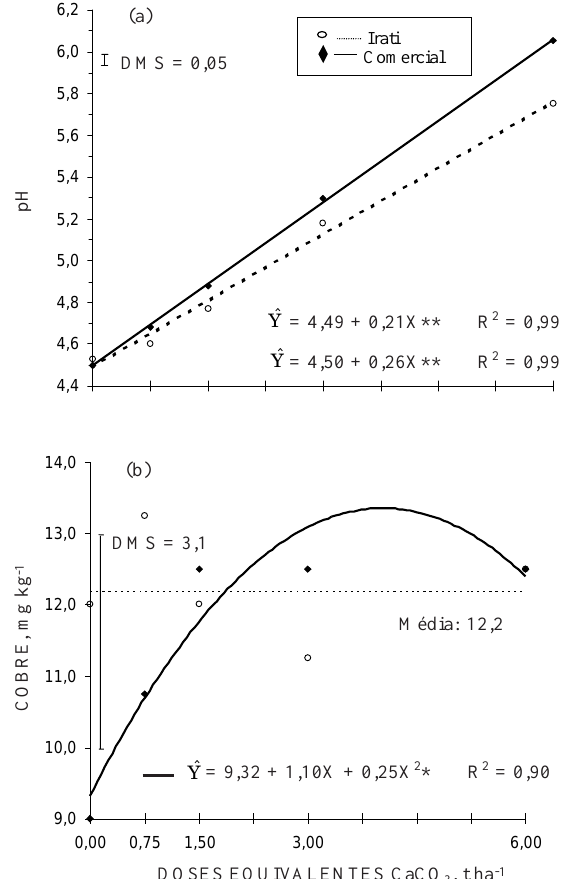
Figura 1. pH do solo em CaCl , após a colheita (a) e 2 concentração de Cu na planta de milho (b) em função de doses crescentes de equivalentes de , e dos distintos materiais corretivos. CaCO 3 (DMS: Diferença mínima significativa para diferentes materiais corretivos a uma mesma